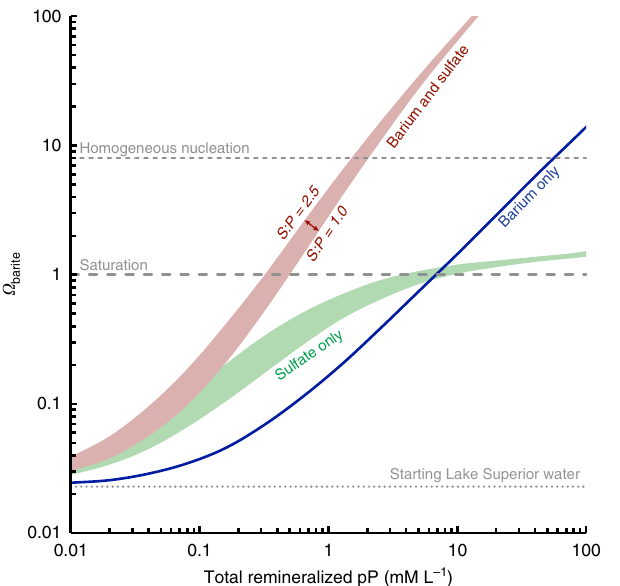
Fig. 5 Barite saturation as a function of organic matter remineralization in Lake Superior. Curves illustrate the evolution of Ω barite in 1-L solutions assuming that both Ba and sulfate, only sulfate, or only Ba are able to accumulate following remineralization. To achieve Ω barite = 1 in the Ba and sulfate scenario, between 92 and 95% of sulfate and 67 and 75% of Ba ions